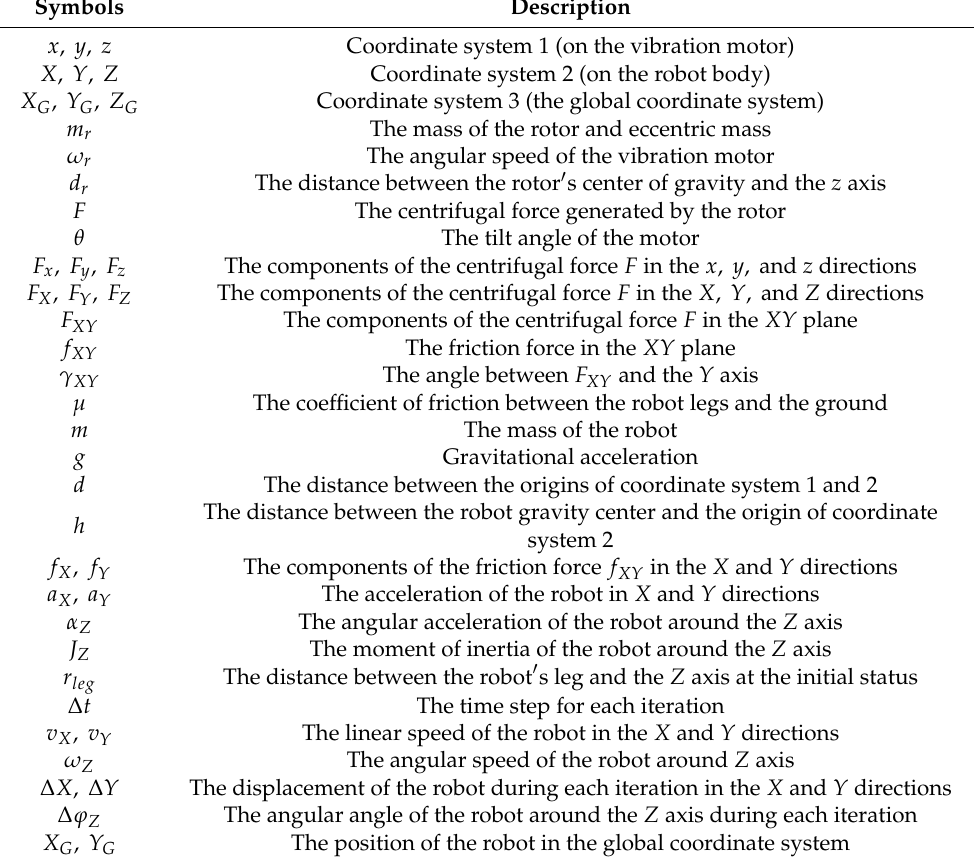
Table A1. List of